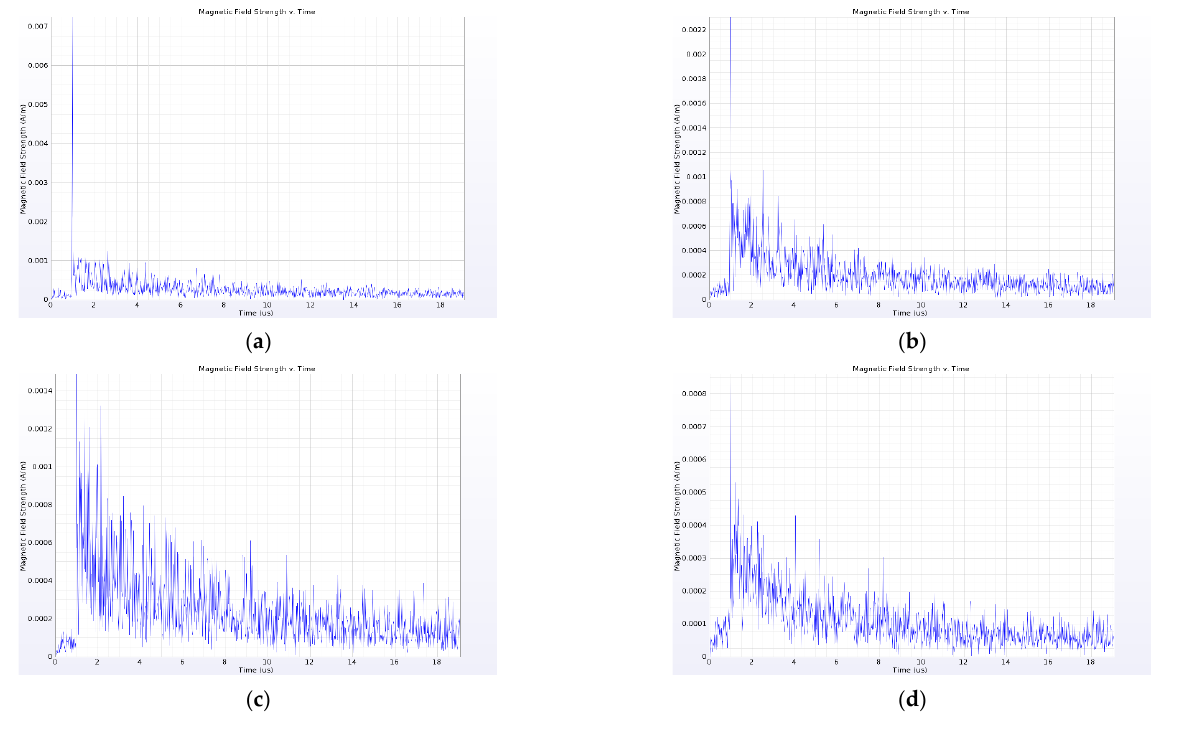
Figure 10. Effect of insulator on near-field propagation characteristics of PD electromagnetic wave signal. ( a ) Magnetic field strength at point sensor 1; ( b ) magnetic field strength at point sensor 2; ( c ) magnetic field strength at point sensor 3; ( d ) magnetic field strength at point sensor 4.